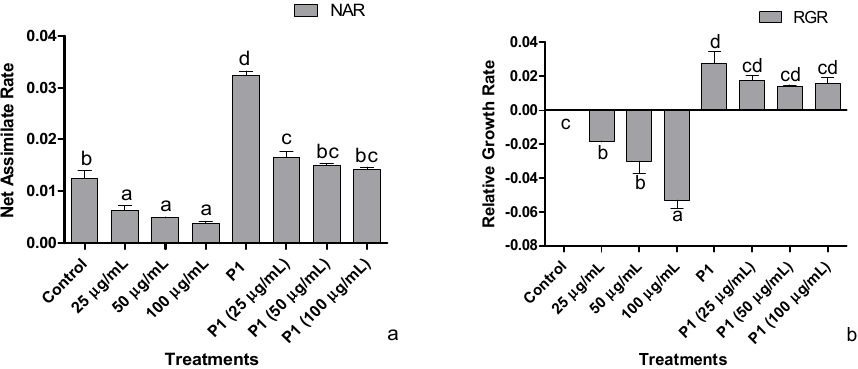
Figure 3. Effects of different concentrations of hexavalent chromium and P1 on ( a ) net assimilation rate and ( b ) relative growth rate of sunflower seedlings grown hydroponically (half-strength Hoagland’s solution) for 16 days in a plant growth chamber. Data are mean of 36 replicates with SE of the mean. Different labels on mean bars represent significance (Duncan; p < 0.05).